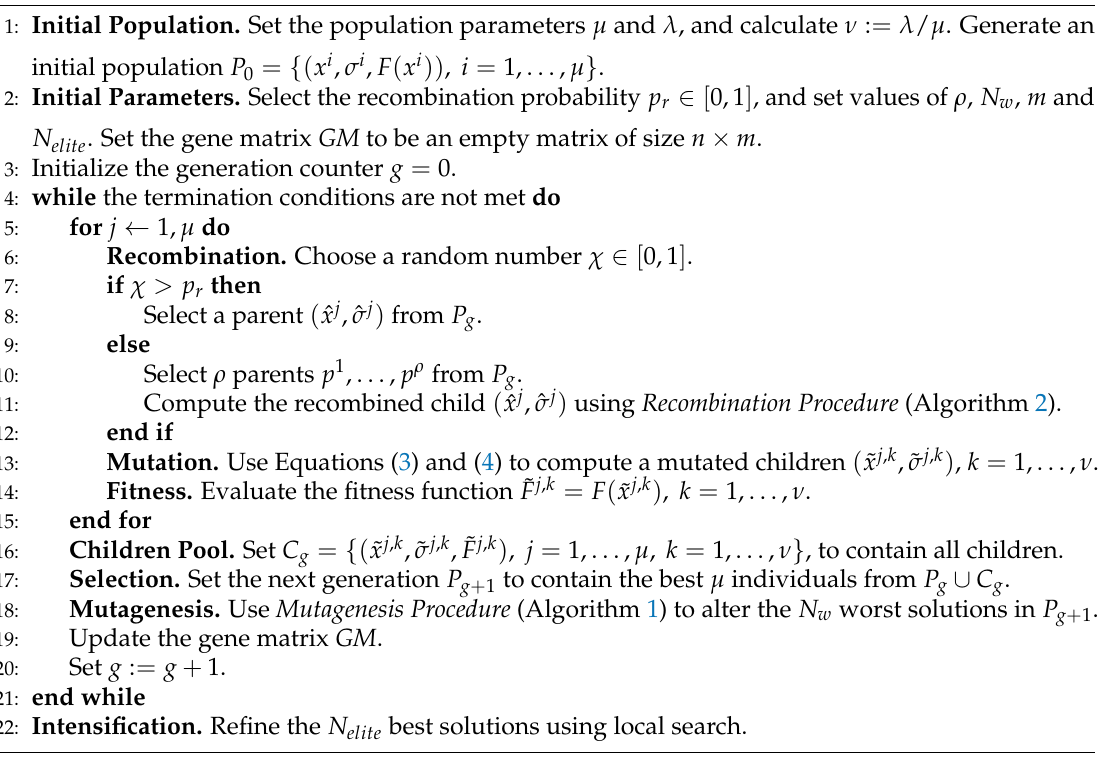
Algorithm 3 DES Algorithm